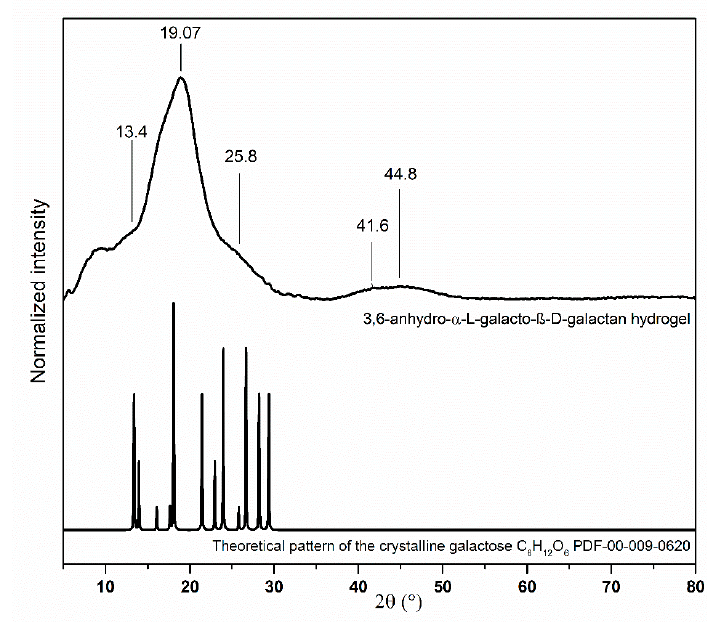
Figure 2. XRD pattern of galactose hydrogel.